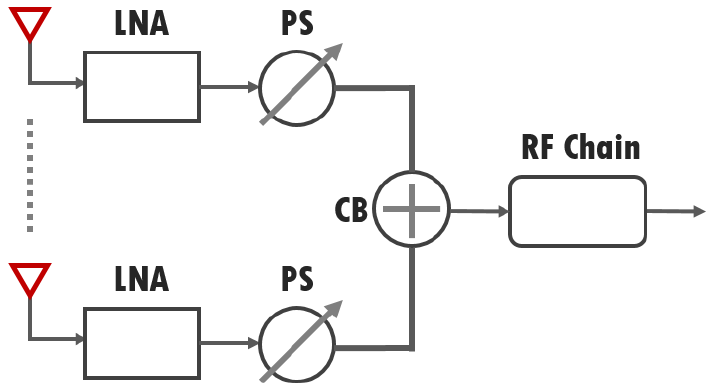
Figure 3. Block diagram of the analog beamforming (ABF).